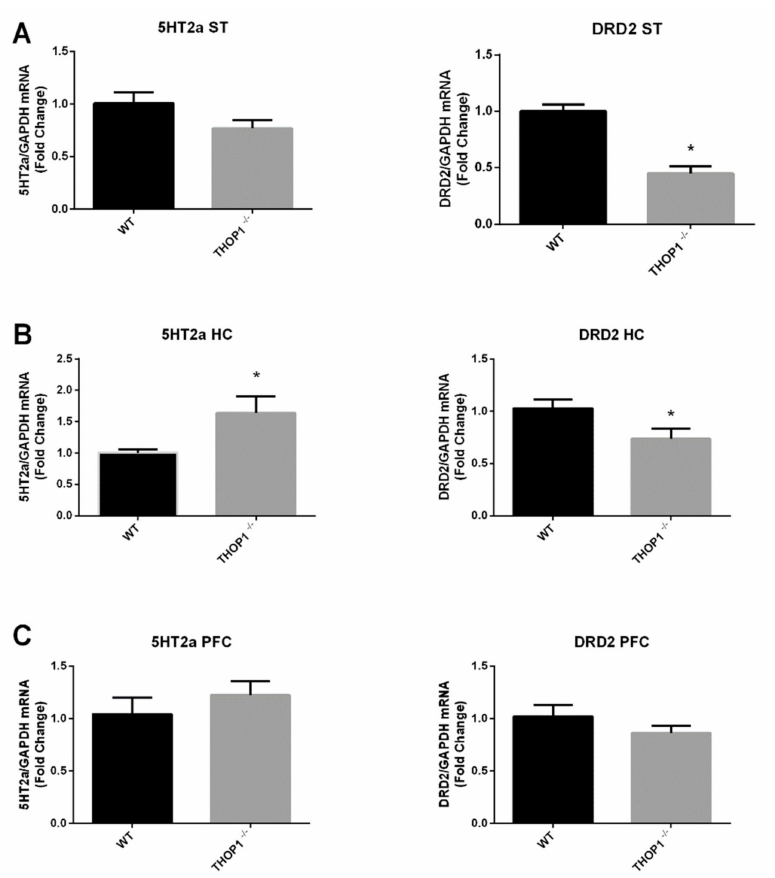
Figure 10. Gene expression of 5HT2a and DRD2 in di ff erent areas of mice brain. THOP1 - / - mice showed upregulation of 5HT2a gene expression in ST ( A ), HC ( B ), and PFC ( C ); whereas, in the same brain areas, DRD2 mRNA showed no changes (A–C). Results are expressed as mean ± S.E.M. Statistical significance was determined by Student’s t -test. * p < 0.05. n =